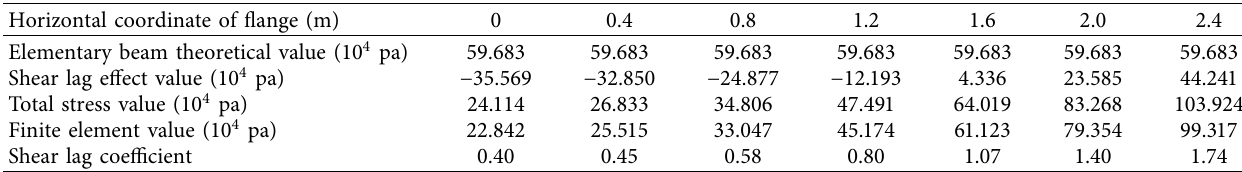
� 12m ; L � L � 6m) (concentrated load). 1 2 3